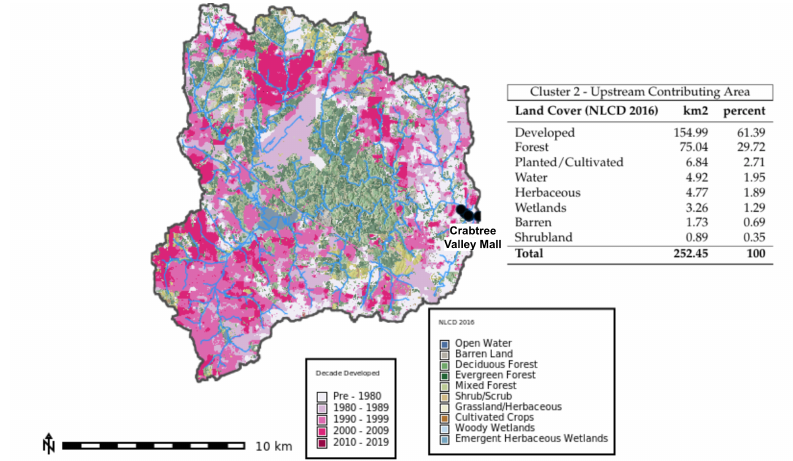
Figure 13. Cluster 2—Cluster 2 has a 252.5 km 2 upstream contributing area that is 61% developed. The problem hotspot (Crabtree Valley Mall) was developed inside the floodplain in the 1970s before an additional 122.83 km 2 of developed land was built upstream. This new development represents a 384% increase in developed land over 40